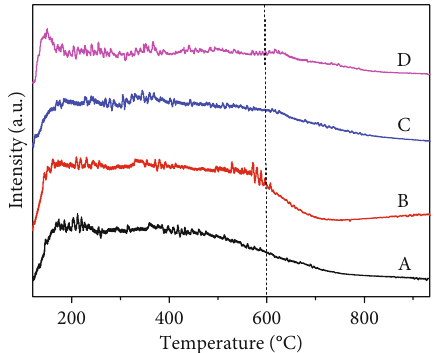
Figure 2: O -TPD pro fi les of (a) Blank-, (b) MEA-, (c) DEA-, and 2 (d) TEA-CeO powders synthesized by solvothermal process 2 combined calcination in air.